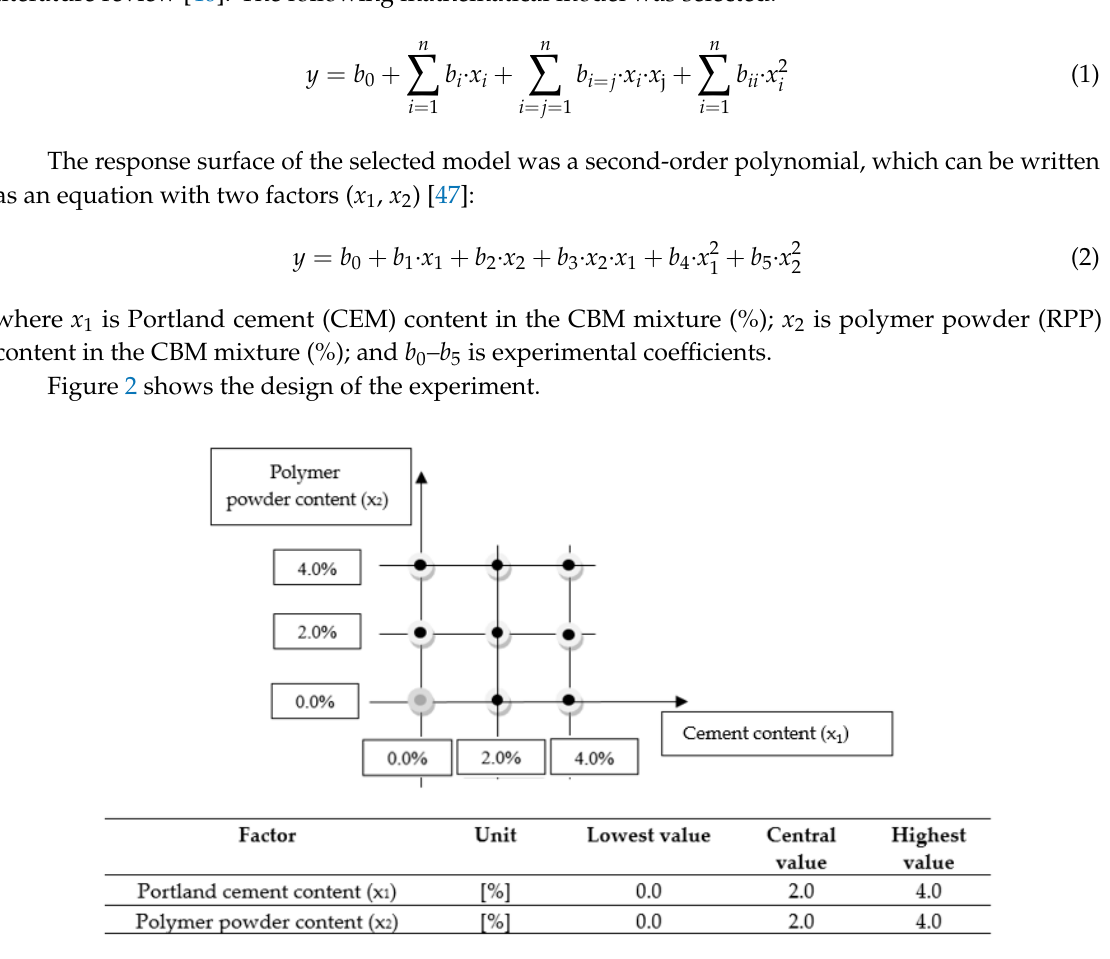
Figure 2. Design of experiment.